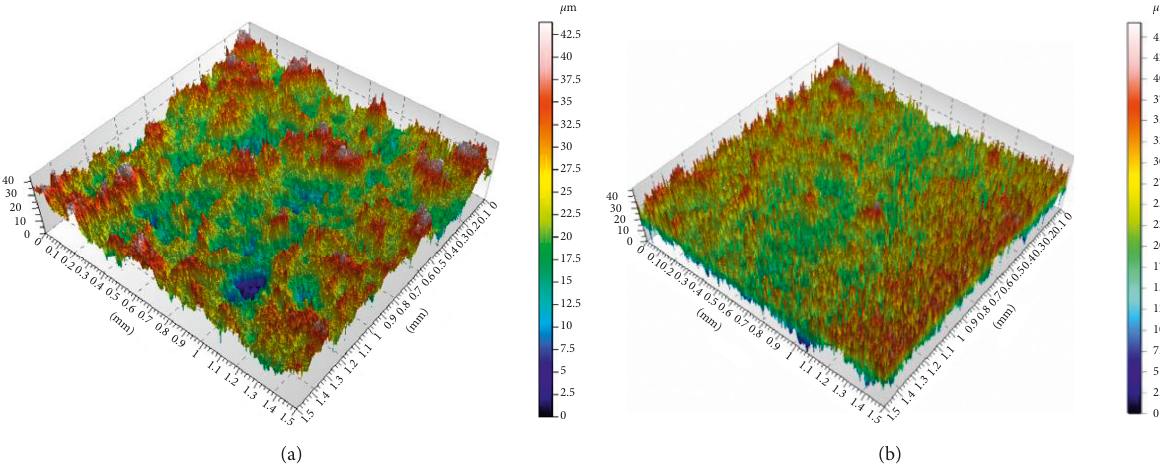
Figure 6: 3D surface images of the (a) shot-blasted surface and (b) zinc phosphate